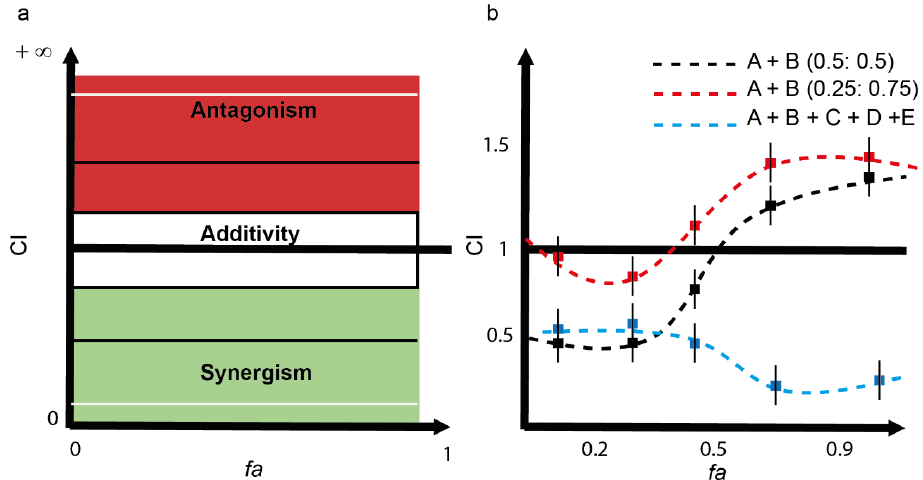
Figure 2. ( a ) Schematic representation of a fa- CI plot. In contrast to the Isobologram, fa -CI plots are effect-oriented graphics (see x -axis). The additivity line is CI = 1; CI < 1 indicates synergism and CI > 1 indicates antagonism. The additivity effect can consider uncertainty (depicted by the white area). The type of combined effect between any combinations of drugs (from 2 to n ) can be shown for the entire range of fractional effect levels (from 0 to 1) without the requirement of extra graphical dimensions; and ( b ) schematic representation of three theoretical mixtures, in the same graphic, the effect-dependent type of interaction of drugs A + B can be visualized for the same mixture (A + B) at two different mixture ratios (0.5:0.5) and (0.25:0.75). In addition, the effect-dependent interaction of a hypothetical complex mixture composed of A + B + C +